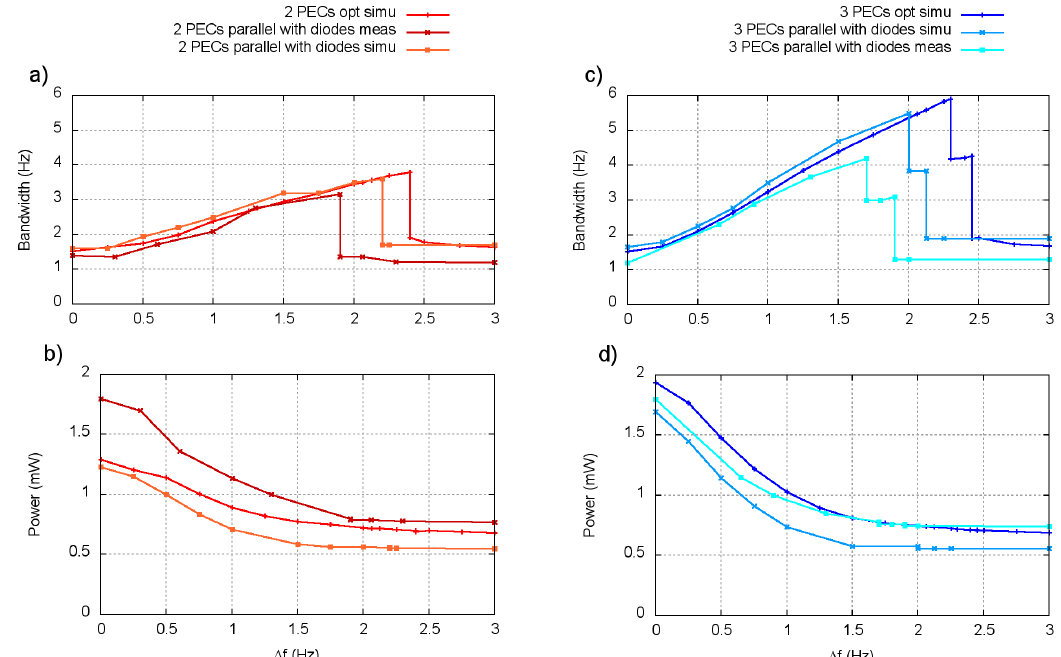
Figure 13. Comparison of the frequency dependency of the bandwidth ( a , c ) and the guaranteed electrical power ( b , d ) between simulation and measurement for arrays with two ( a , b ) and three ( c , d ) PECs. Appl. Sci. 2017 , 7 , 1324